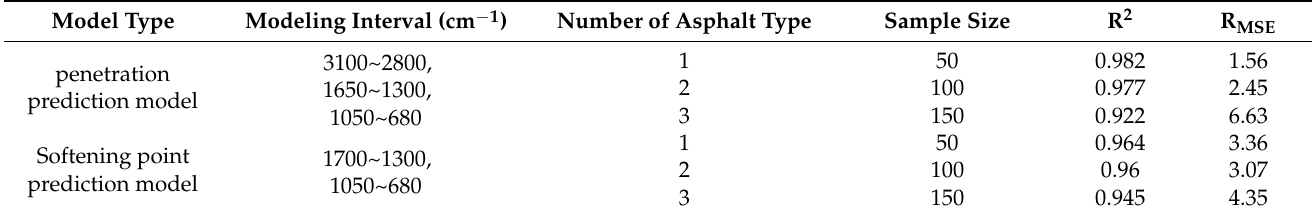
Table 6. Parameters results for softening point and penetration